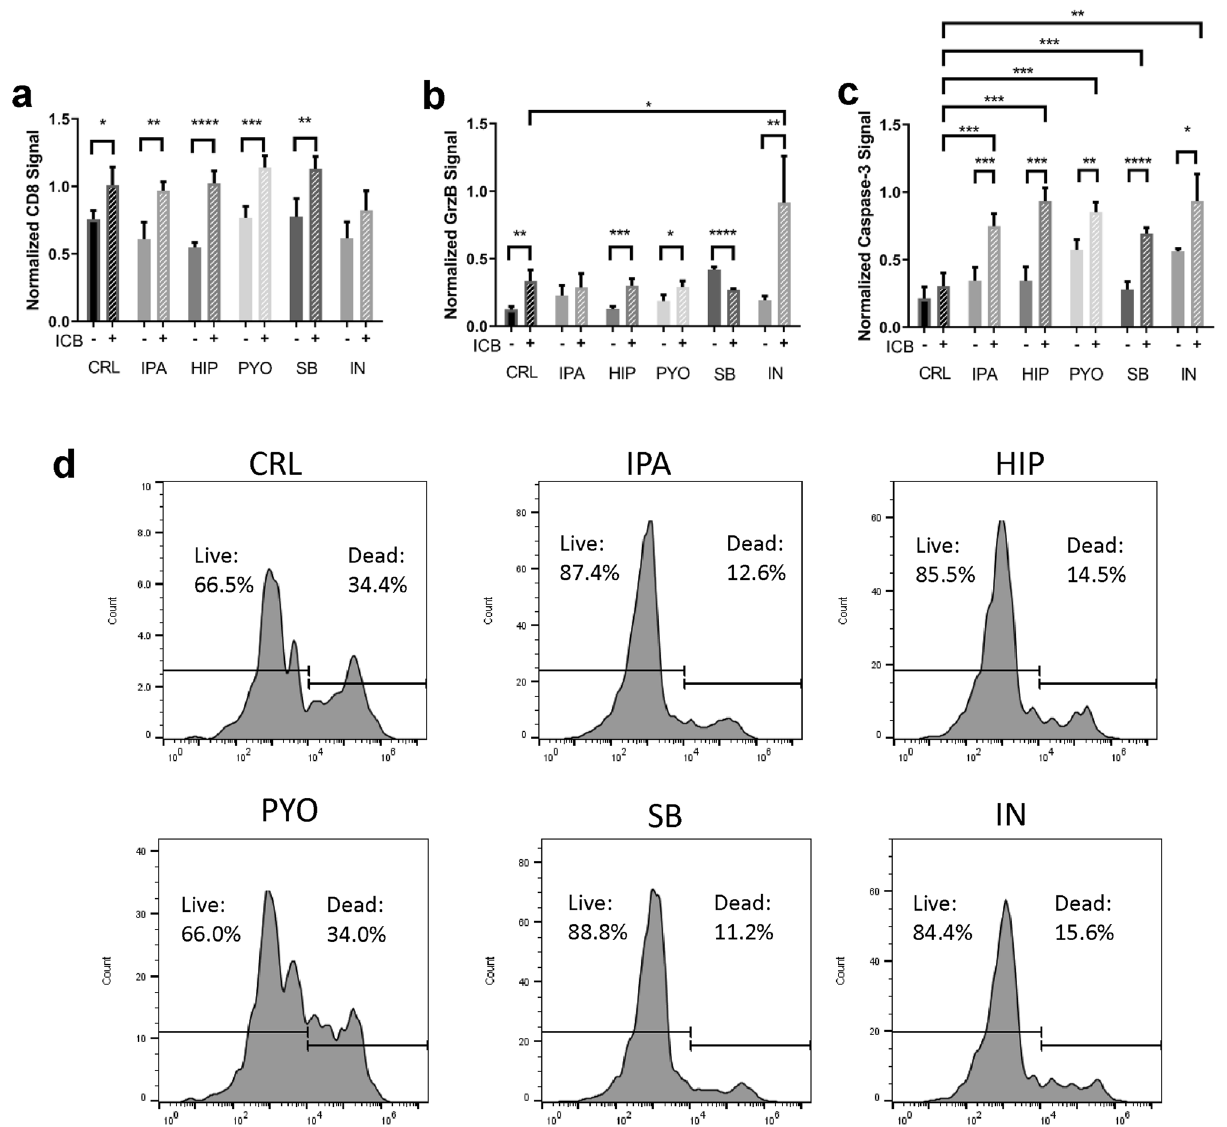
Figure 6. The effects of bacterial metabolites and ICB combinations on immune cell cytotoxicity in iTOs ( a – c ) CD8 ( a ), Granzyme B ( b ), and cleaved caspase-3 signals ( c ) normalized to DAPI signal in iTOs (n = 4 ROI). ( d ) Viability of the CD8 + immune cell population in the different metabolite treated samples, all samples treated with ICB (data representative of 3 organoids